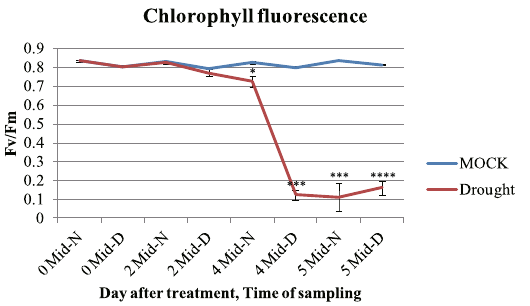
Figure 6. Diurnal alterations in chlorophyll fluorescence and total chlorophyll content in rice leaves under drought stress. Chlorophyll fluorescence (Fv/Fm) was measured in leaf samples from non-stressed MOCK plants (0) and drought-stressed plants (2, 4, and 5), collected mid-day (Mid-D) and mid-night (Mid-N) for periods indicated: 2 Mid-D and 2 Mid-N, sampled for 2 d; 4 Mid-D and Mid-N, sampled for 4 d; and 5 Mid-D and 5 Mid-N, sampled for 5 d. Error bars indicate standard errors of 3 replicates. * , ** , *** , and **** : values are significantly different from each other at P ≤ 0.05, P ≤ 0.01, P ≤ 0.001, and P ≤ 0.0001,